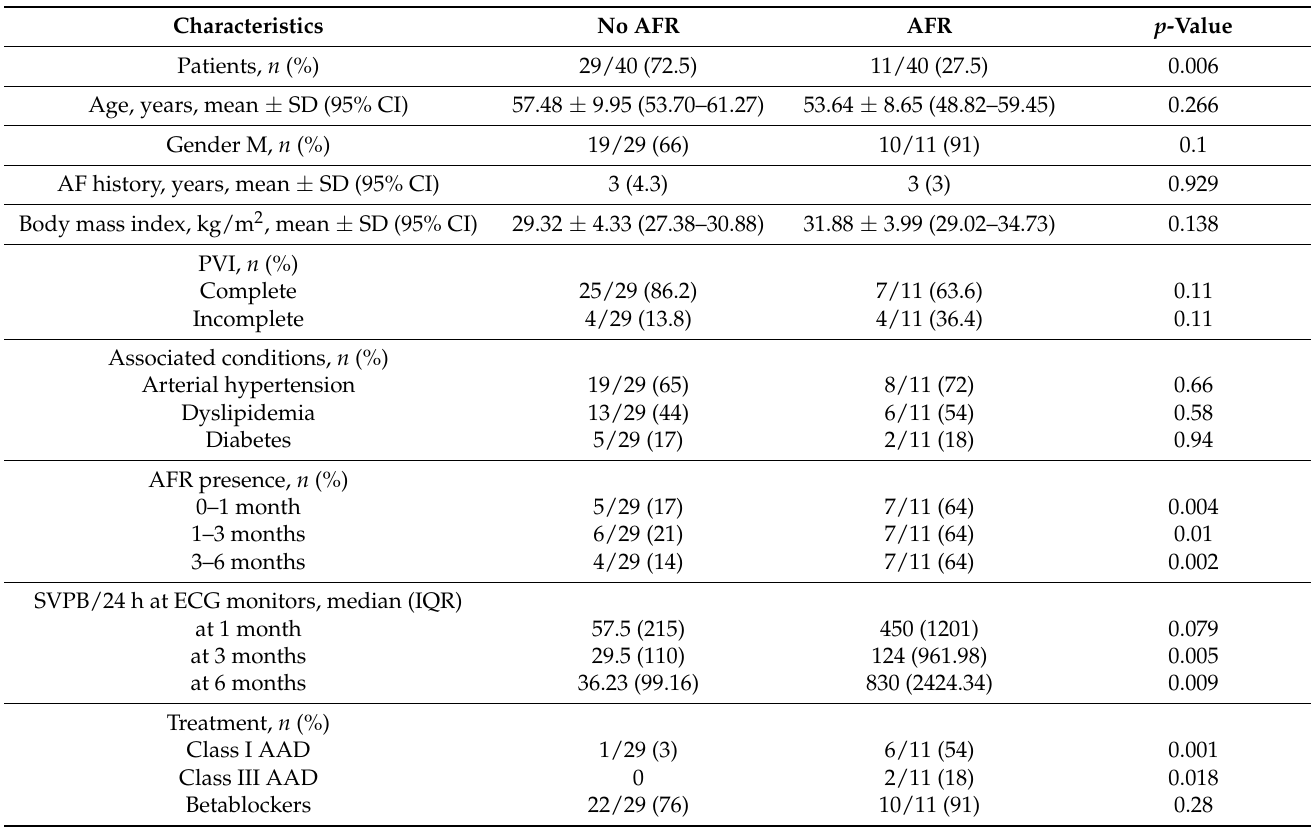
Table 3. Characteristics for patients with and without AFR between 6–12